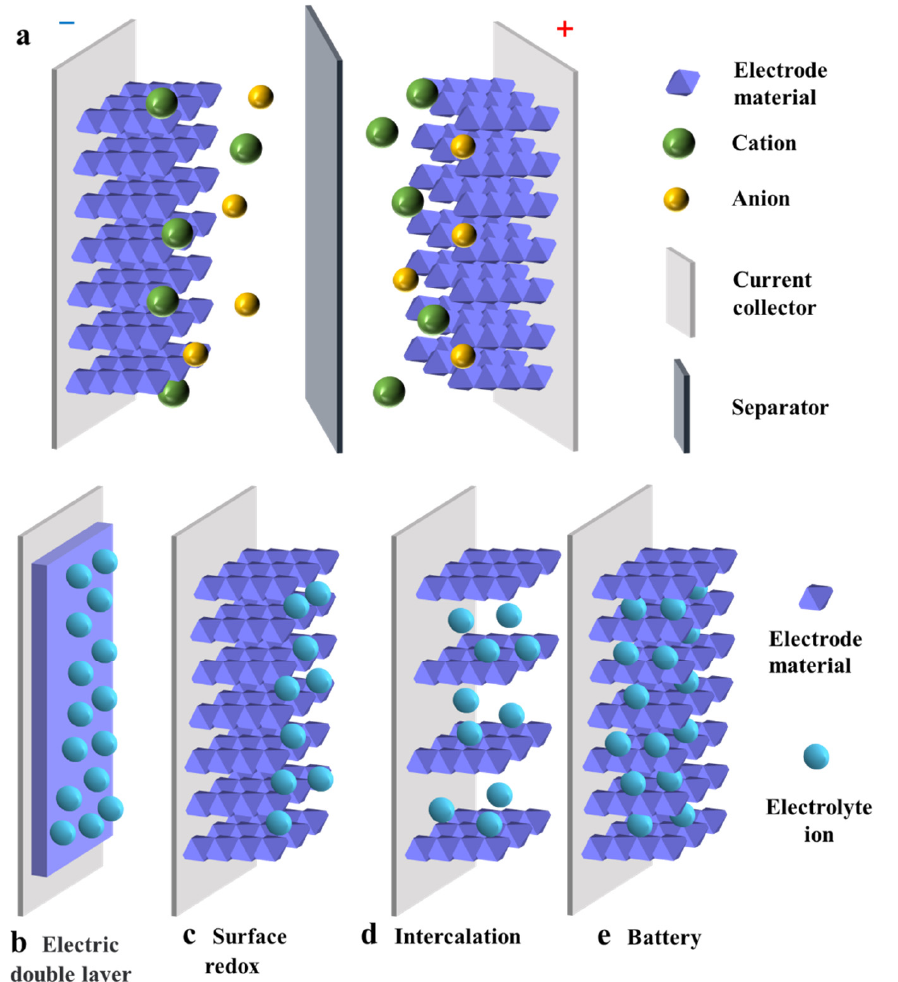
Figure 1. ( a ) Schematic diagram of the structure of an SC and energy storage mechanism of ( b ) an electric double layer capacitor, ( c ) a surface redox capacitor, ( d ) intercalation capacitor and ( e ) a battery-type capacitor.